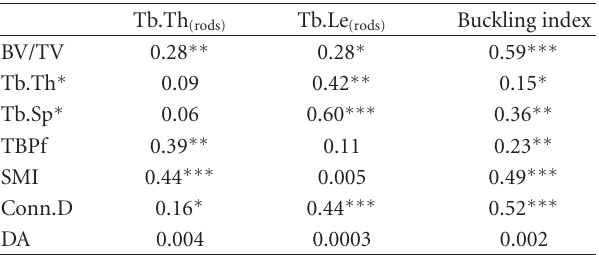
Table 2: Statistical correlations between micro-CT-derived param- eters and anaglyph-derived parameters ( ∗ P < .05; ∗∗ P < .01; ∗∗∗ P < .001).